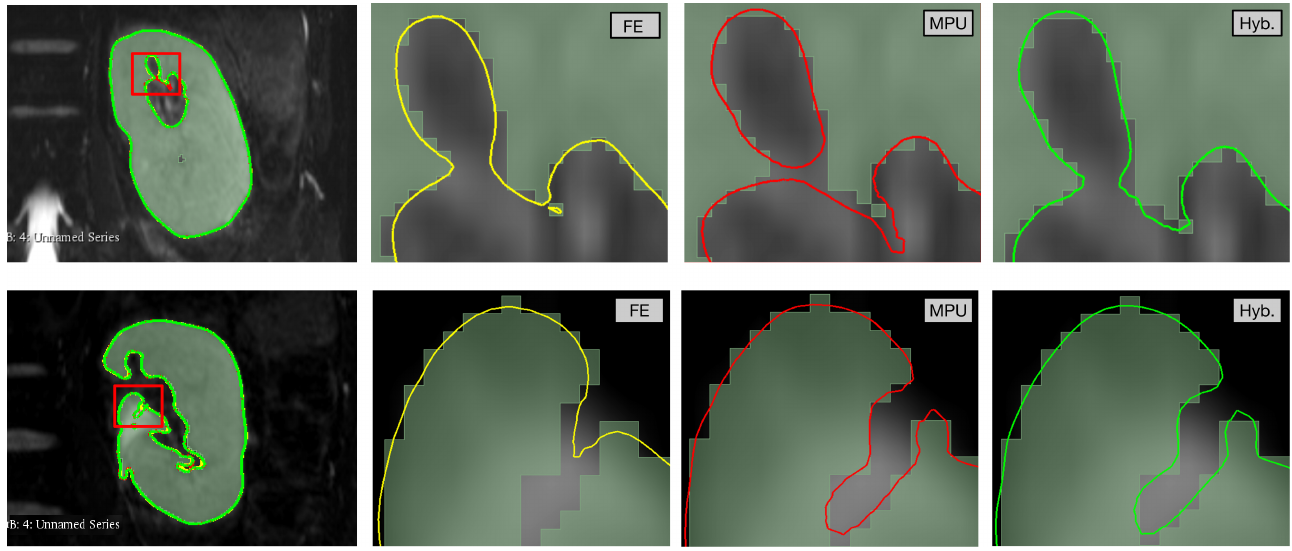
Figure 5. A visual evaluation of the Kidney model, reconstructed with FE (yellow), MPU (red), and Hybrid (green). From left to right: overlaid models followed by a zoom on the highlighted areas showing the reconstruction result of each